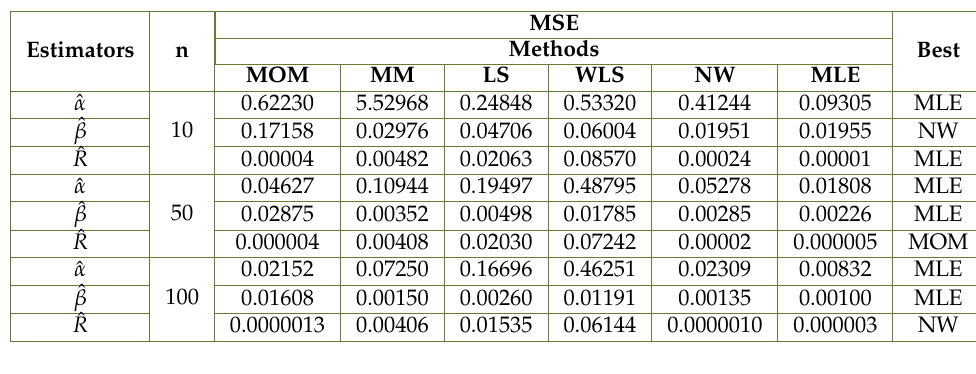
Table 4. Estimated values for ( α , β ) and ( R ) using ( E 3 )